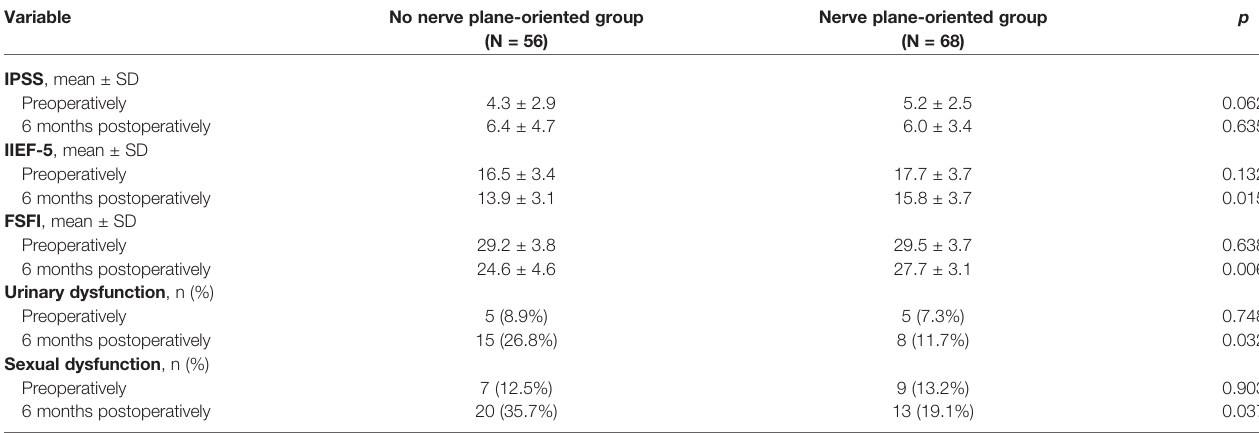
TABLE 2 | Urinary and sexual function of participating patients. Variable No nerve plane-oriented group